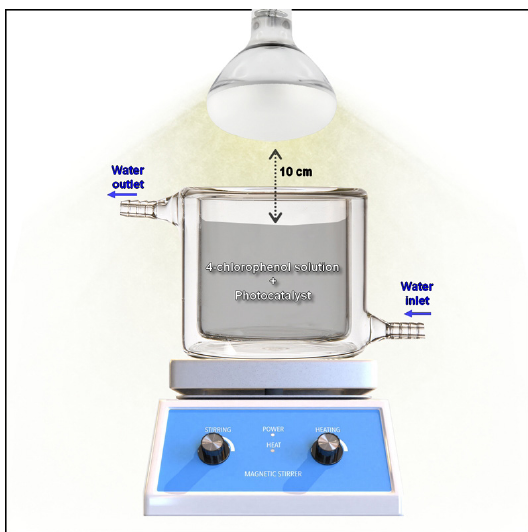
Figure 1. Reactional system used for the photocatalytic tests.